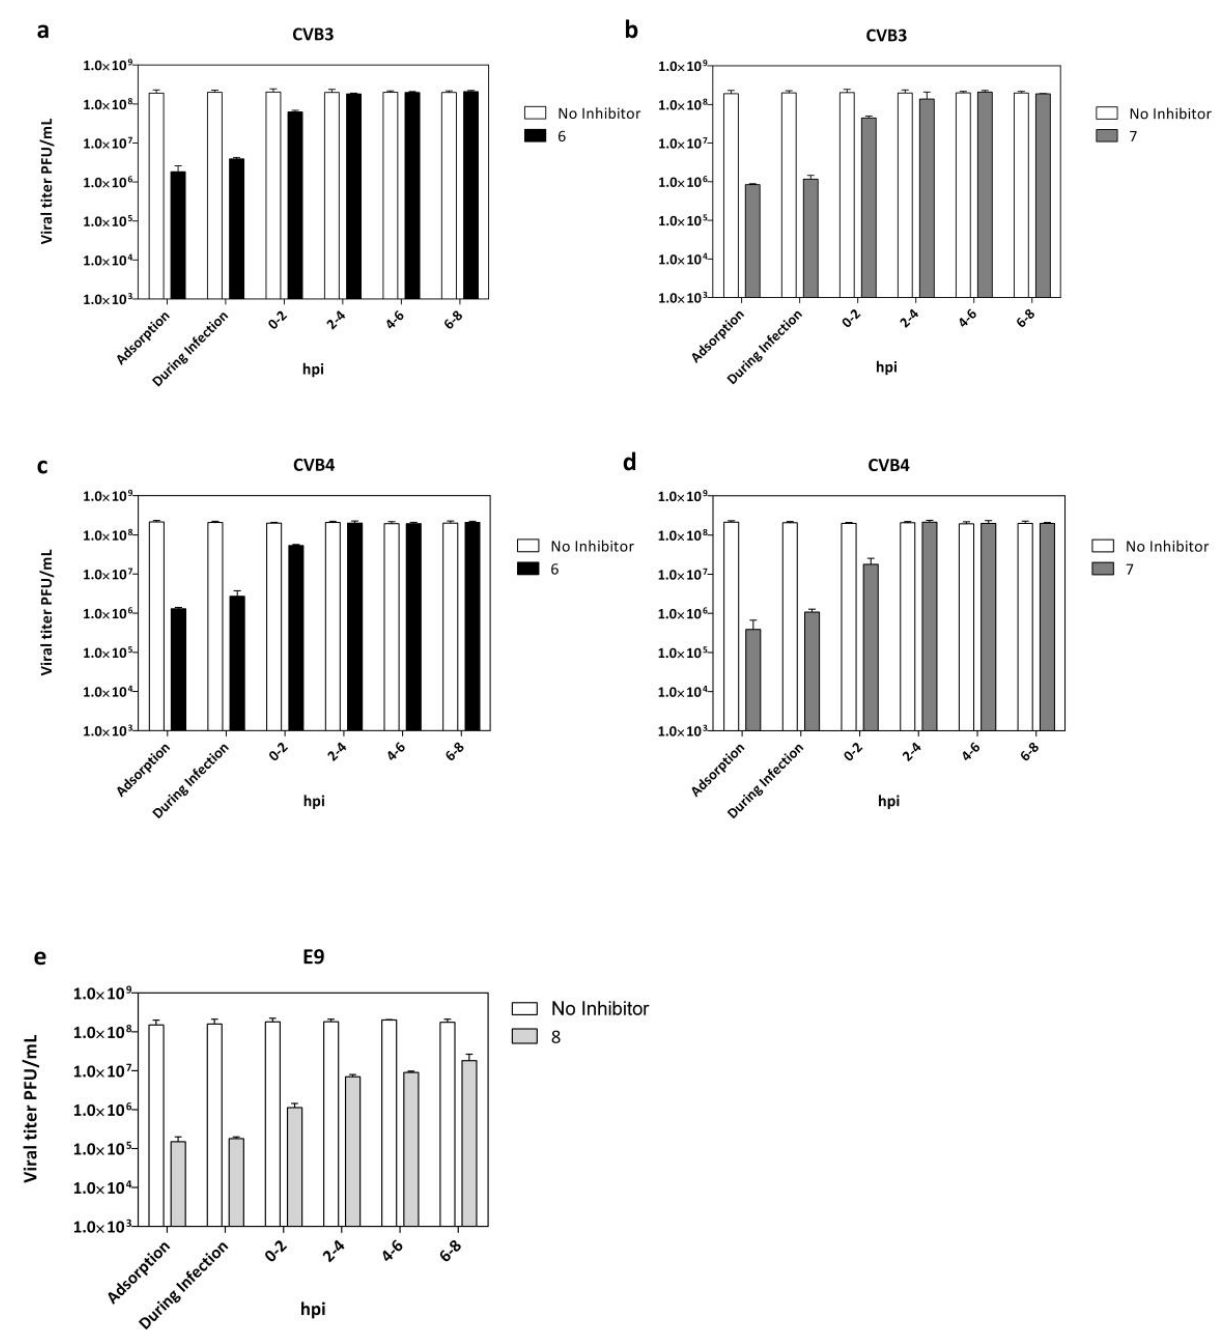
Figure 3. Adsorption assay and time of addition for derivatives 6 and 7 against CVB3 ( a , b ) and CVB4 ( c , d ) and derivative 8 against E9 infection ( e ). White columns: viral yield for control untreated cells; dark columns: viral yield in cells treated with compounds 6 (black), 7 (dark grey), and 8 (grey). Data are presented as mean ± SD from three independent experiments.